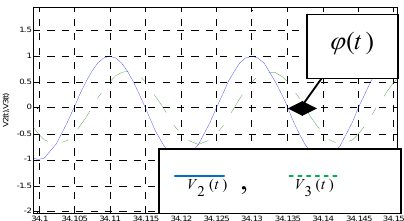
Fig.7. Evolution of V